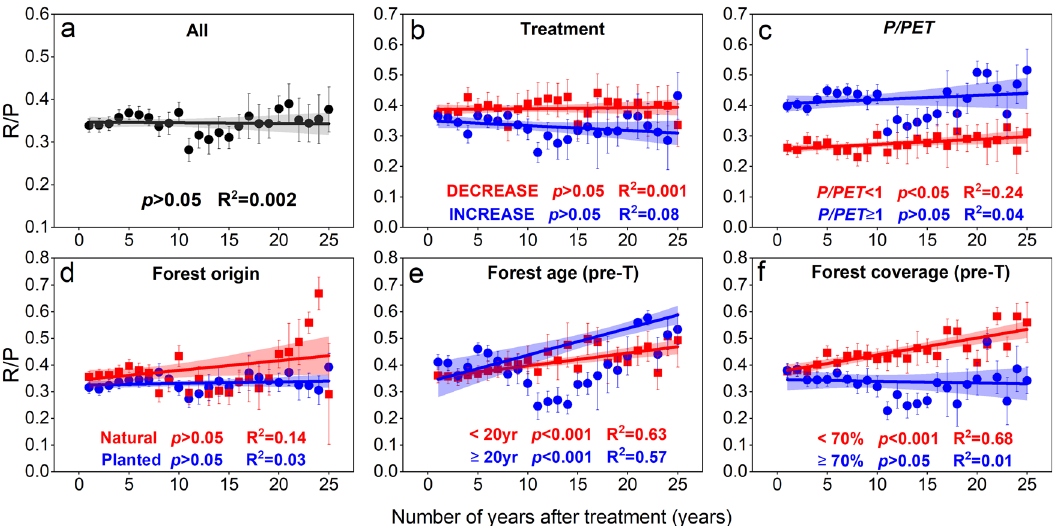
Fig. 3 Temporal trends of forest runoff coef fi cient ( R / P ) under natural growth. a All the 278 watersheds with 2 – 25 years of measurement records; b the watershed of DECREASE and INCREASE treatments; c P /PET < 1 and P /PET ≥ 1 regions; d planted and natural forests; e forest ages (pre-treatment); f forest coverage (pre-treatment). Error bars indicate the standard error of mean. Shaded area represents 95% con fi dence